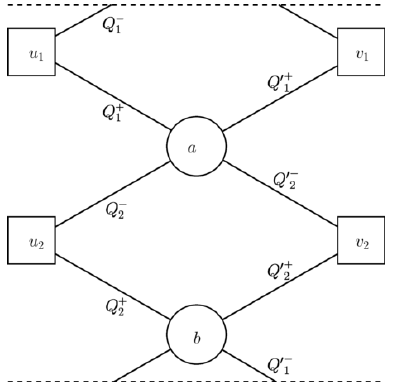
Figure 3 . The E 7 surprise theory. The boxes are su (2) (cid:13)avor groups, circles su (2) gauge groups. Fields Q (cid:6) have charge (cid:6) 1 under u (1) (cid:11) , and (cid:12)elds Q 0(cid:6) i drawn on a cylinder and has quartic superpotential interactions preserving the four su (2)s and the two u (1)s. All the (cid:12)elds have R-charge